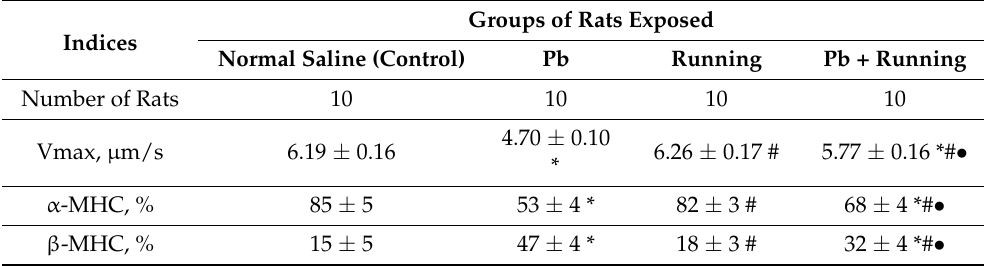
Table 3. Maximal velocity of reconstituted thin filament sliding over RV myosin and the ratio of α - and β -myosin heavy chains in the right ventricle.